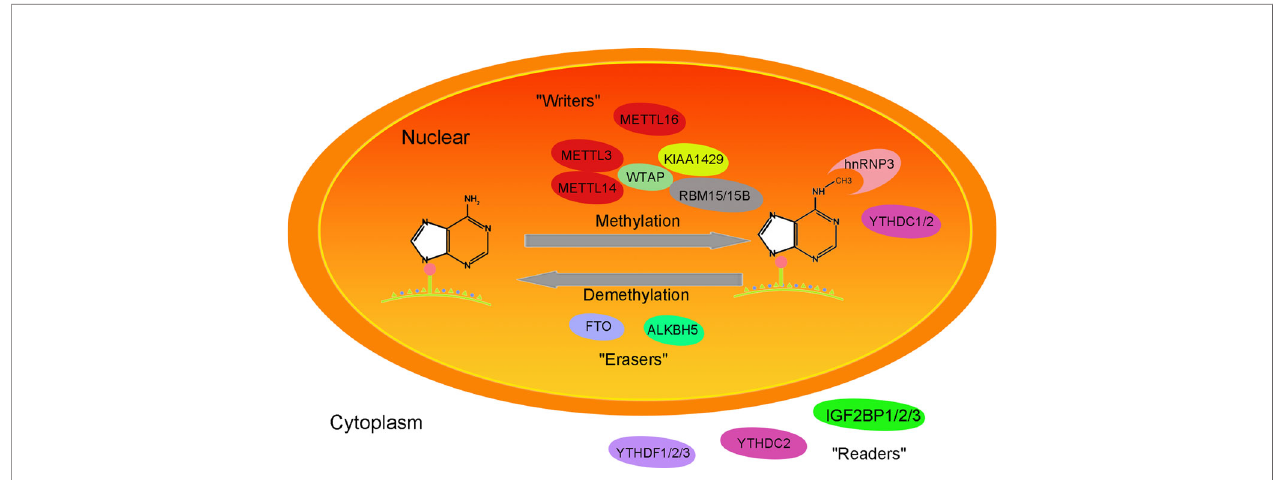
FIGURE 1 | Mechanism of the function of the m6A methylation-related enzyme